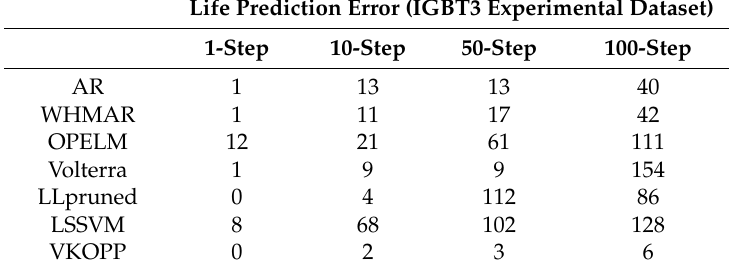
Table 8. The life prediction error result for different methodologies.